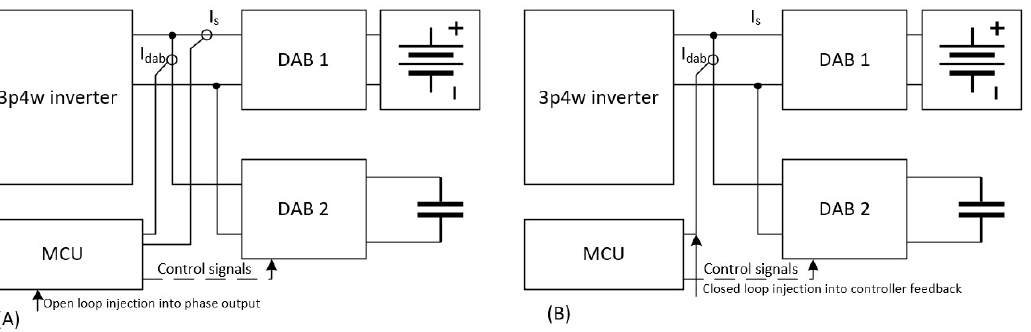
Figure 9. Laboratory bench diagrams for frequency domain evaluation of the compensator system—( A ) setup for open loop evaluation of the compensator, ( B ) setup for closed loop evaluation of the compensator.